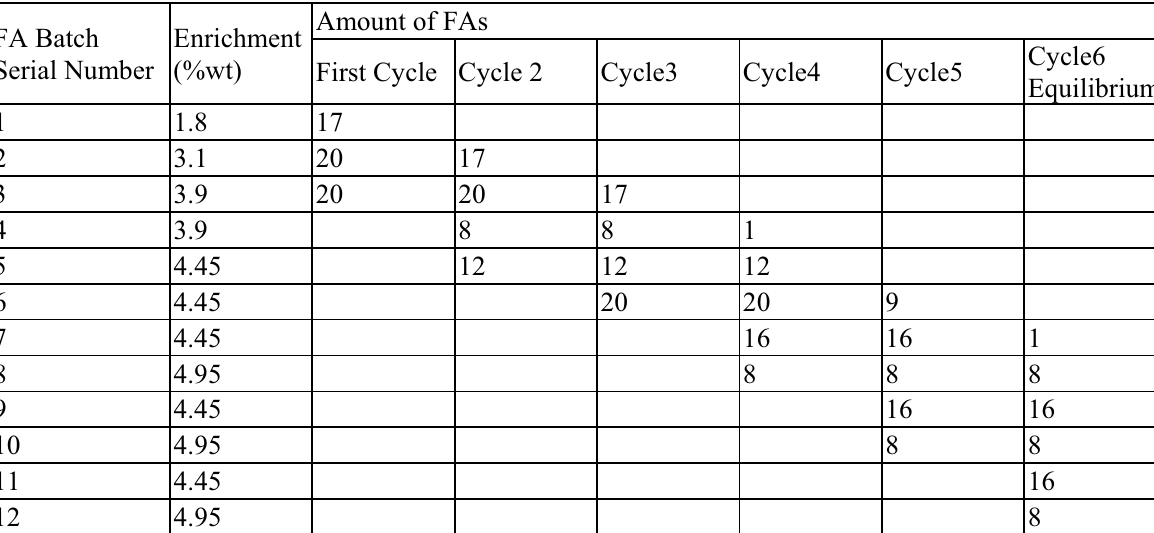
Table III.: FAs Usage of Boron and CRs Co-Controlled Core